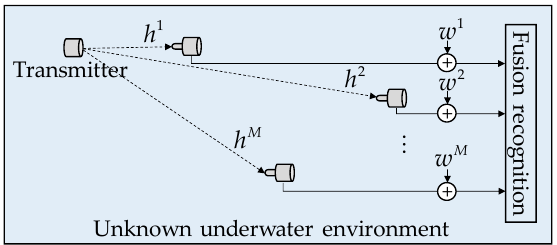
Figure 2. Modulation recognition method based on deep learning in multiple reception scenarios.